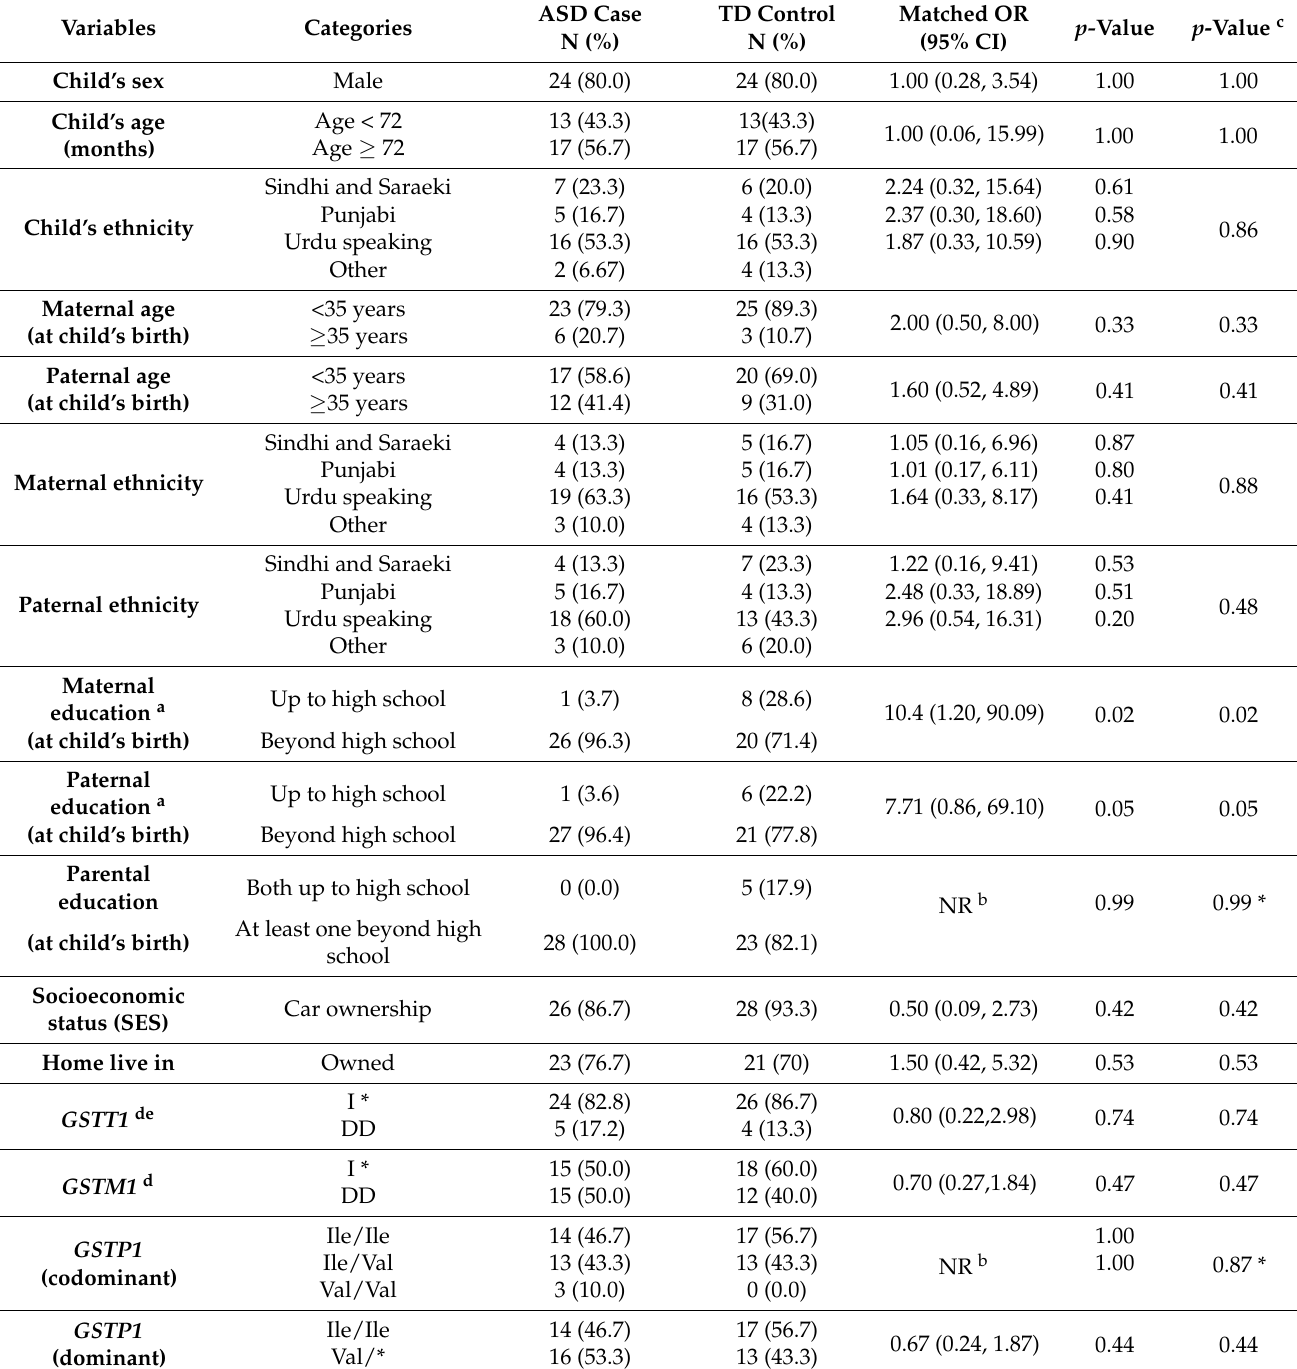
Table 1. Characteristics of children and their parents by ASD case status (30 matched